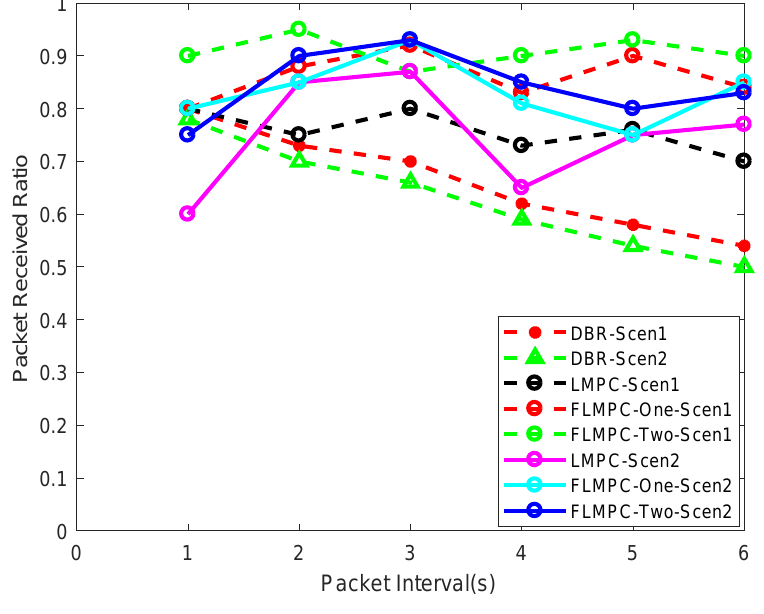
Figure 12. Packet Received